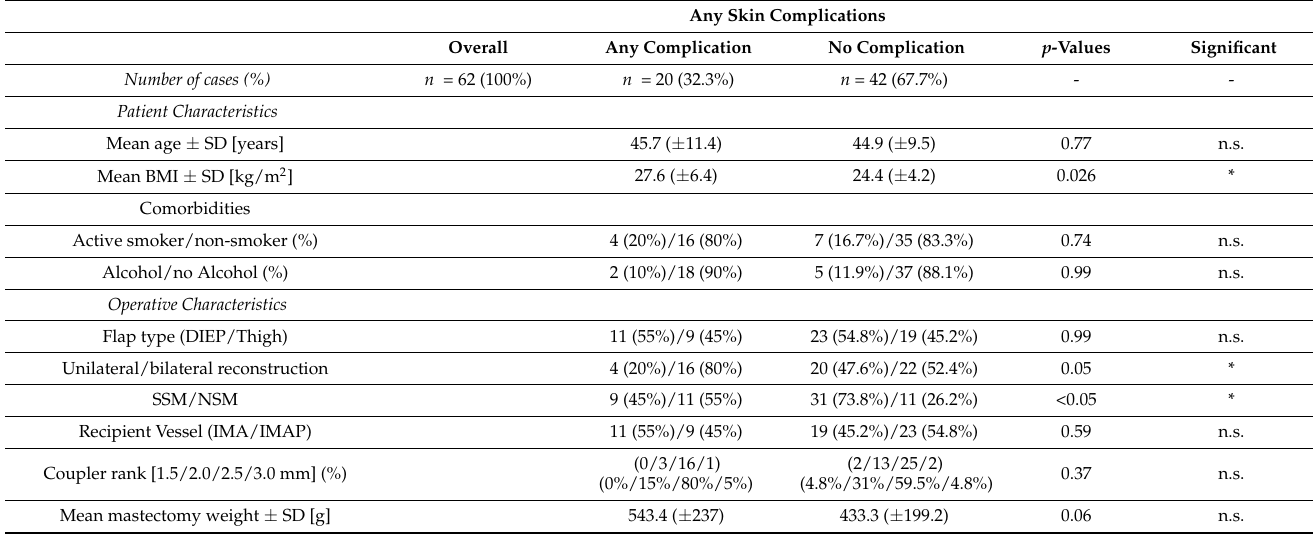
Table 3. Univariate analysis of risk factors between patients with and without skin